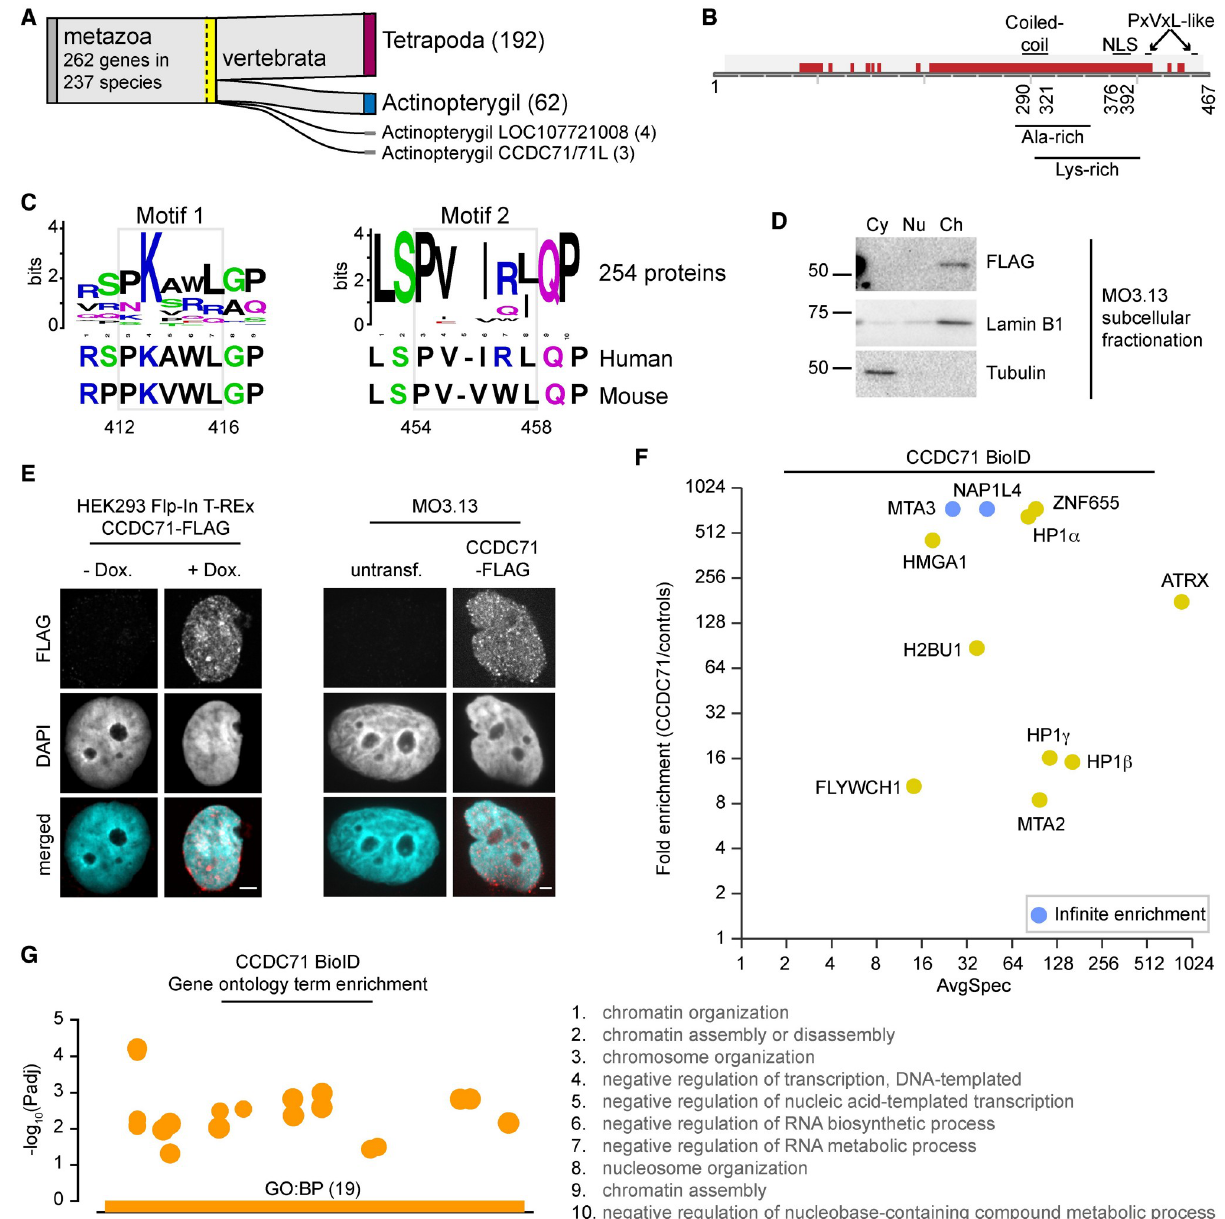
Fig 3. CCDC71 is a chromatin-bound protein that associates with HP1. A: Hierarchical catalogue of orthologs (OrthoDB v10.1) [56] diagram showing 262 putative genes within the CCDC71/71L family. B: Graphical depiction of the CCDC71 primary structure and features identified using Pfam [110] and Prosite [111]. Putative PxVxL-like motifs are also shown. The CCDC71/71L domain is shown in light grey and putative disordered regions in dark red. C: Sequence analysis of 254 CCDC71 orthologs aligned around the two PxVxL-like motifs. The sequence alignment was generated using COBALT [112] and visualized using WebLogo [113]. D: Subcellular fractionation of MO3.13 cells expressing FLAG-CCDC71. E: Immunolabeling of exogenous CCDC71 in HEK293 Flp-In and MO3.13 cells. F: Fold enrichment of CCDC71 BioID prey (BFDR � 5%, SAINT [103]) over negative controls. Data were obtained from biological duplicates. G: Gene ontology terms represented in the CCDC71 BioID. Scale bars = 4 μ m. (G4) structures can form at telomeres, where they cause DNA damage if not properly resolved. The analysis was therefore repeated in cells exposed to the G4-stabilizing small molecule, pyri- dostatin [63], but the treatment had no impact on the SLF2/SMC5—telomere signal overlap (Fig 4B).